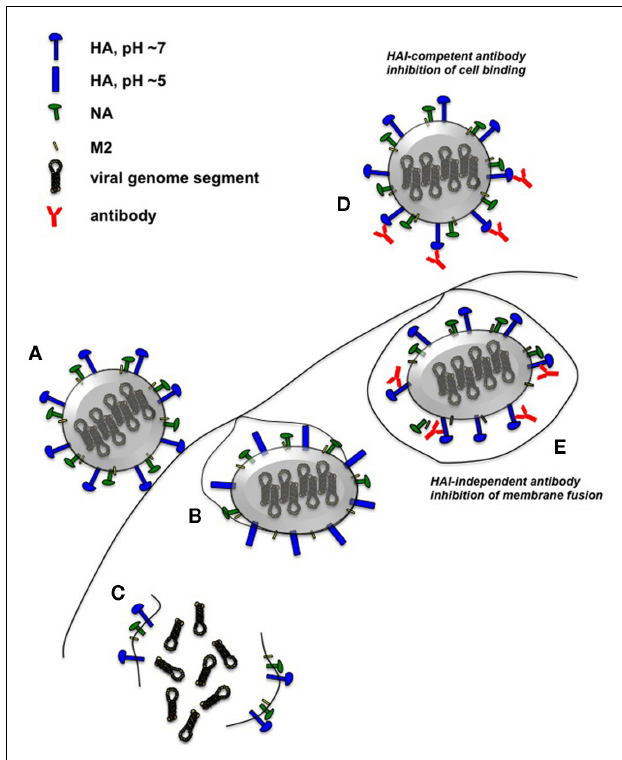
FIGURE 2 | Influenza virus infection and mechanisms of HA-specific neutralizing antibodies. Unimpeded influenza virus binds to receptors on the host-cell plasma membrane (A) and is internalized.The resulting vesicles become acidified via the M2 proton channel.This pH reduction results in HA conformational change that catalyzes the fusion of the host vesicle membrane with the viral envelope (B) .The virion is subsequently dissociated into the cytoplasm (C) , followed by transport of the ribonucleoprotein viral genome segments into the nucleus for replication and transcription (not shown). HAI-competent antibodies that bind to HA globular head effectively inhibit virion binding to host cells, preventing virus entry (D) . HAI-independent neutralizing antibodies that react with the HA stalk region can prevent the conformational changes of this antigen and prevent fusion of viral envelope with host membrane (E) . Not drawn to